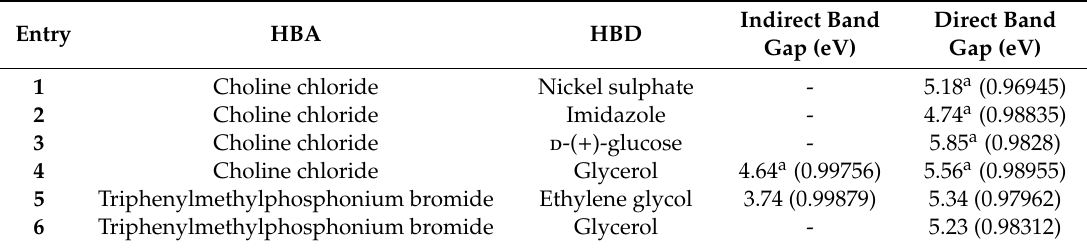
Table 2. Indirect and direct band-gap energies for Systems 1 – 6 . Pearson’s coe ffi cient of corresponding linear fitting reported in parentheses.